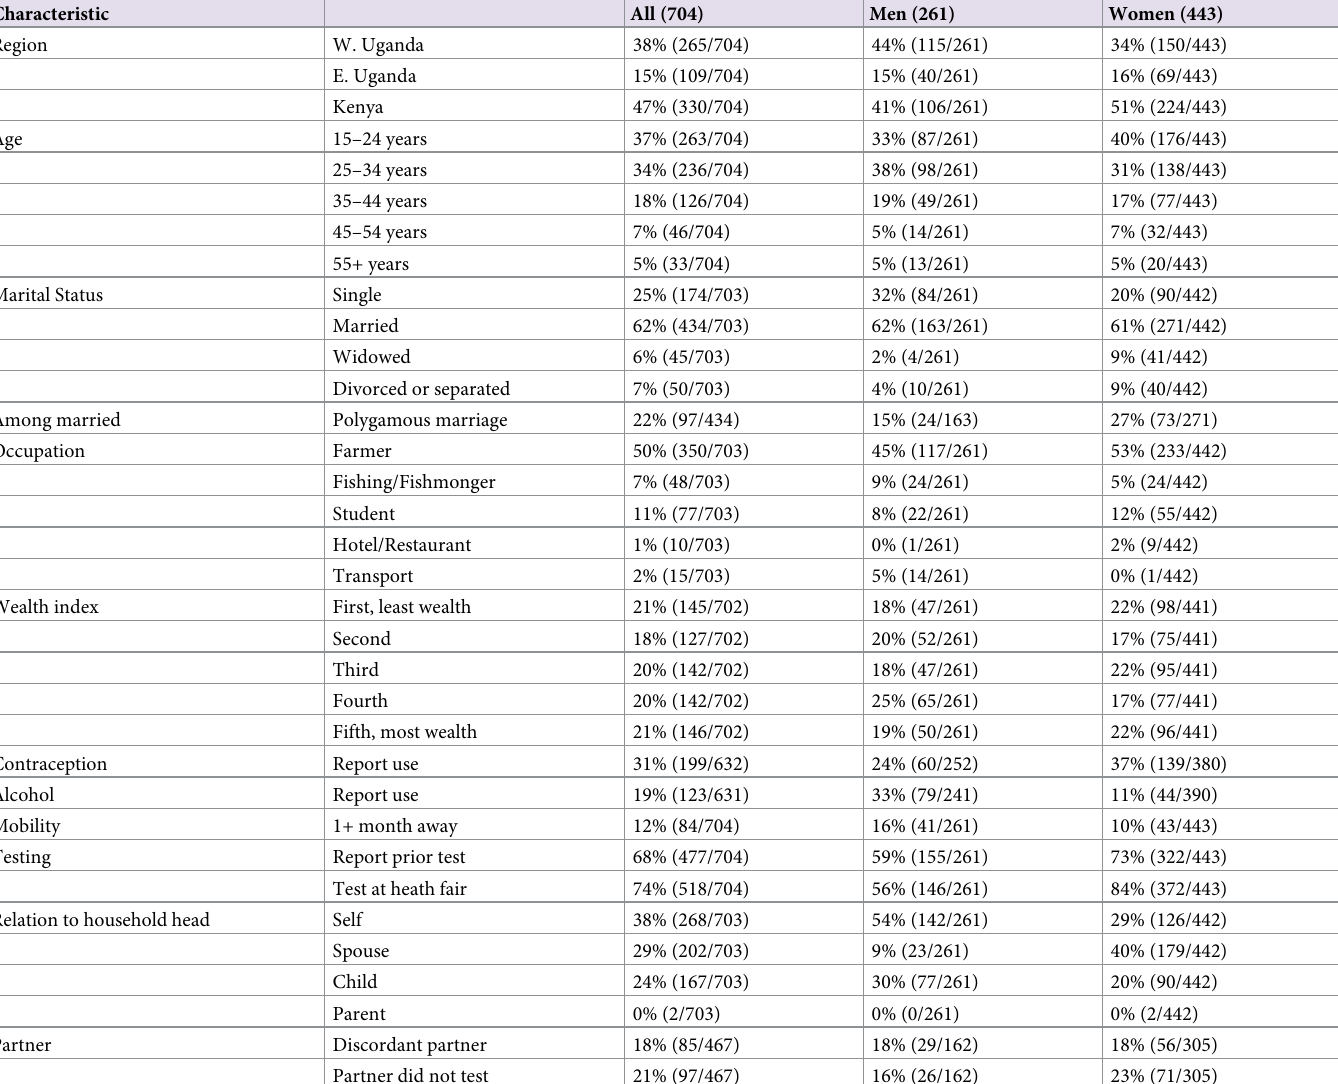
Table 1. Descriptive characteristics in percent (numerator/denominator) of 704 seroconverters identified in the SEARCH test-and-treat trial in 32 rural Uganda and Kenyan communities, overall and by